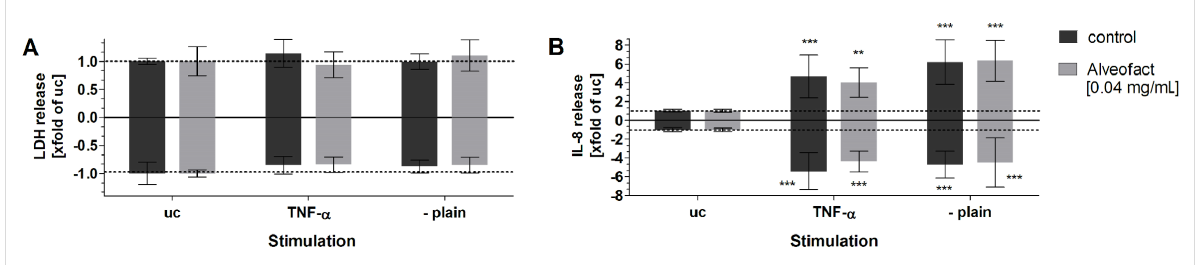
Figure 6: Cytotoxicity and inflammatory responses of aSNP–plain (100 µg/mL) in combination with alveolar surfactant (Alveofact (0.04 mg/mL), exam- ined on the coculture model of the air-blood barrier A549/ISO-HAS-1. aSNPs were apically (A549) applied simultaneously with Alveofact ® in serum- free cell culture medium. A: LDH release was measured after 4 h aSNP incubation (membrane integrity, as xfold of untreated control with a previous normalization to the maximum release (lysis control = 100%)). Cells were then washed and cultured for further 20 h in fresh serum-containing cell culture media (4 h/20 h). B: IL-8 release was measured after 4 h/20 h and depicted as xfold of untreated control (uc). Upper columns: apical compart- ment, lower columns: basolateral compartment for both LDH and IL-8. Positive control: TNF- α 300 U/mL. Data are depicted as means ± S.D. of 3 independent experiments with n = 3. For statistical analysis two-way ANOVA with Bonferroni´s post test was conducted. * P < 0.05, ** P < 0.01 and *** P < 0.001 compared to the untreated control.